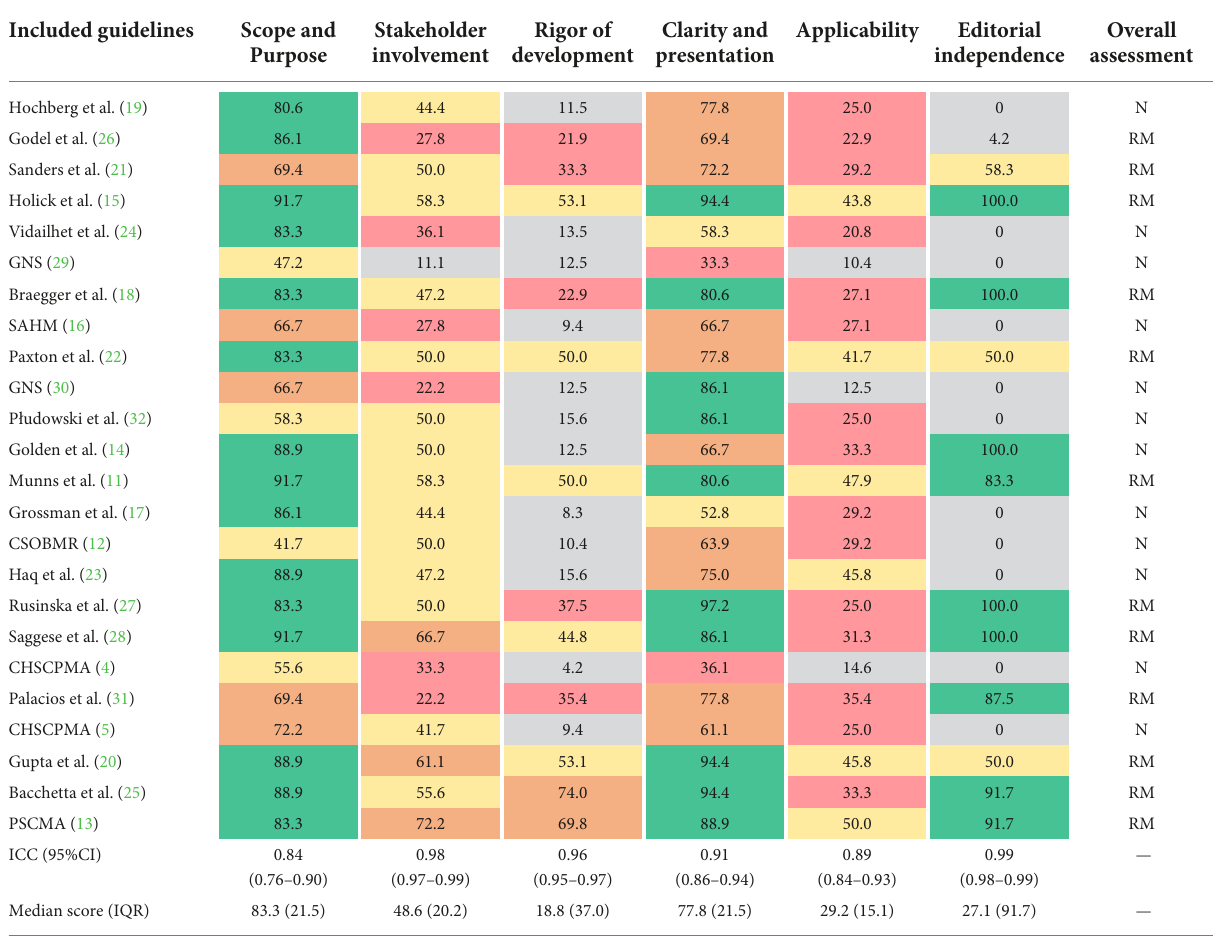
TABLE 2 Appraisal of Guidelines for Research and Evaluation II (AGREE II) scaled domain score (%) and ICC score of included guidelines and consensus. Included